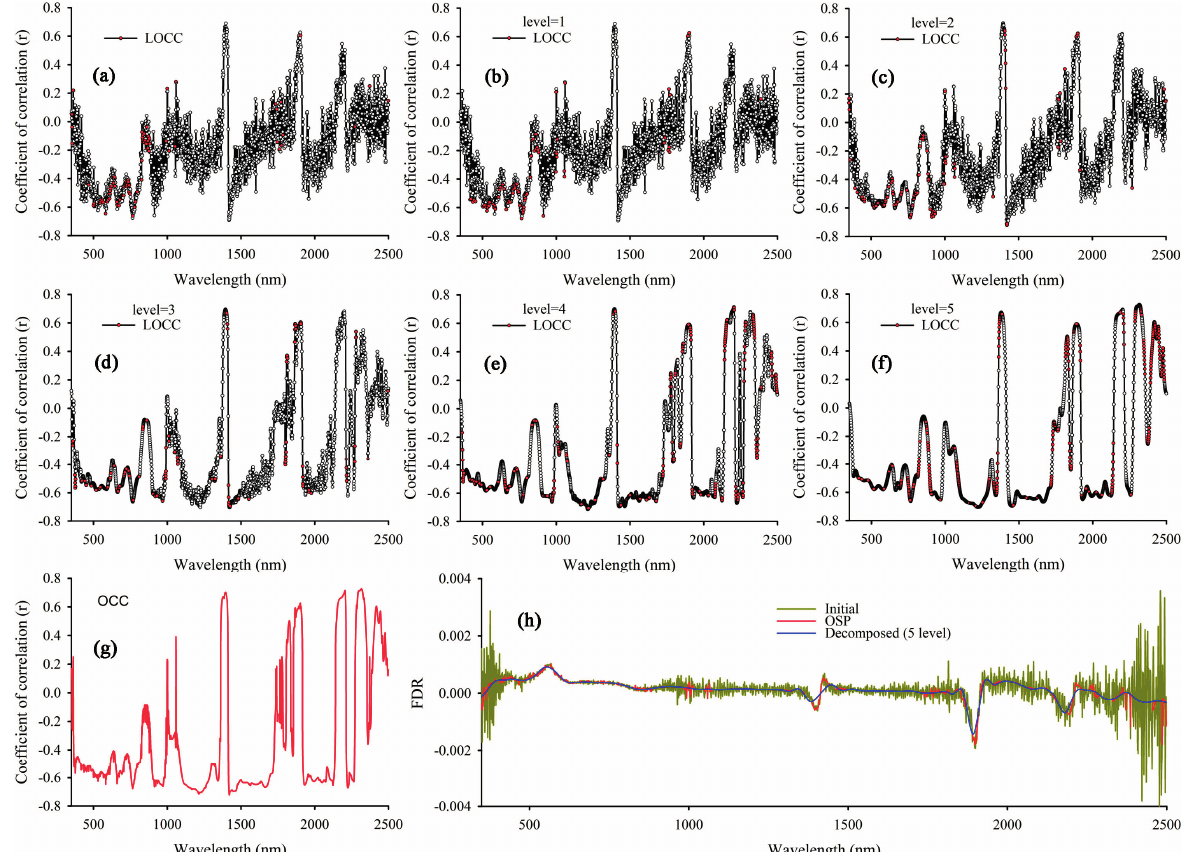
Figure 6. Wavelength dependence on coefficients of correlation between total soil nitrogen (TN) and first derivative differential of the soil spectra: initial ( a ); decomposed (1–5 levels) ( b – f ); optimal correlative curve (OCC) ( g ); and ( h ) first derivative